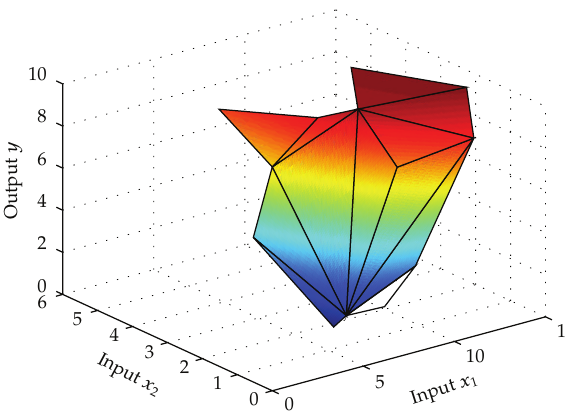
Figure 3: Fully e ffi cient